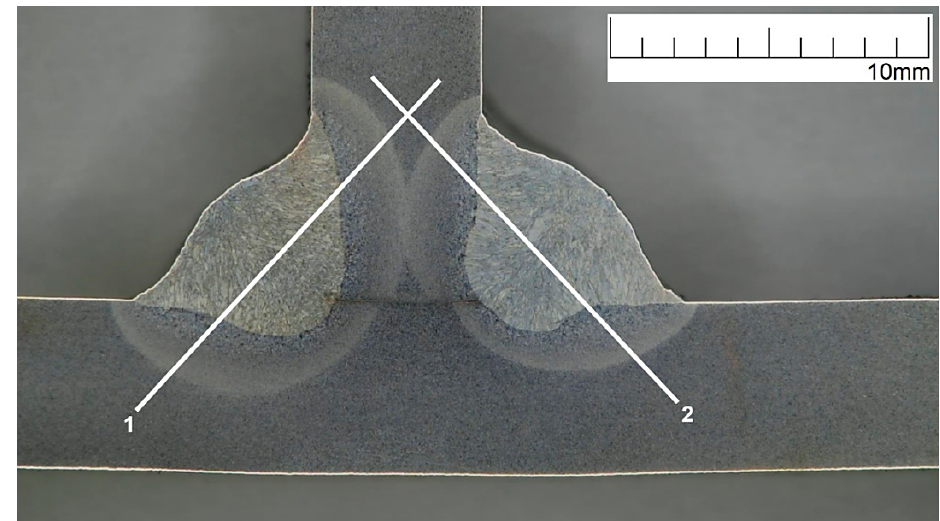
Figure 19. Macrostructure of welded joint with HV5 hardness measurement lines marked.